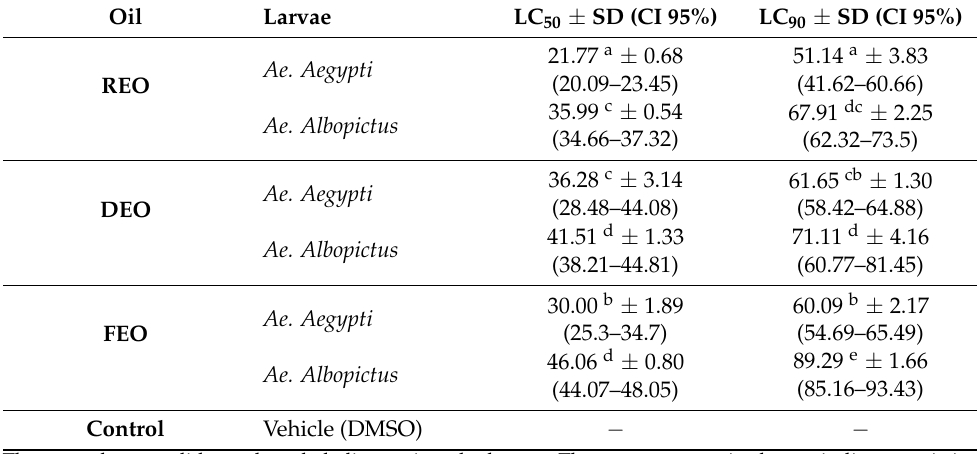
Table 3. Median lethal concentration of essential oil from L . grata leaves against third-instar